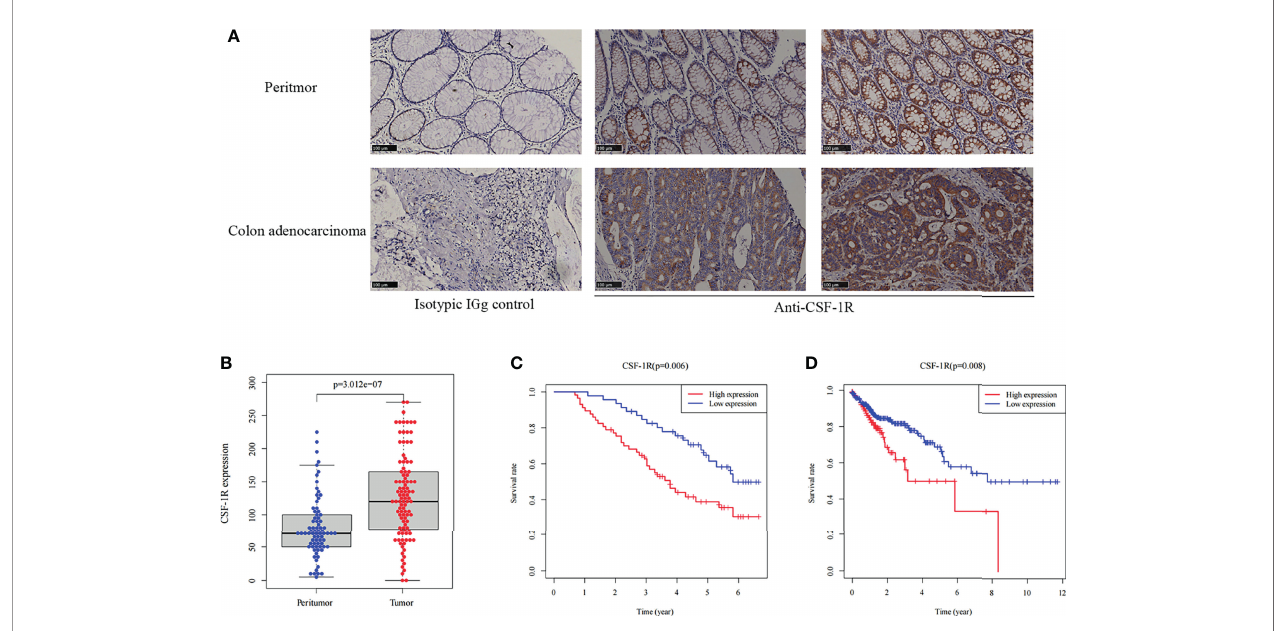
FIGURE 1 | CSF-1R is highly expressed in COAD and associated with dismal prognosis. (A) Representative images of immunohistochemical in colon adenocarcinoma and peritumor tissues. (B) The boxplot of the CSF-1R expression between the tumor and peritumor tissues in 103 COAD patients. (C) Kaplan- Meier curves for low versus high CSF-1R expression in 103 COAD patients. (D) Kaplan-Meier curves for low versus high CSF-1R expression in TCGA COAD cohort.